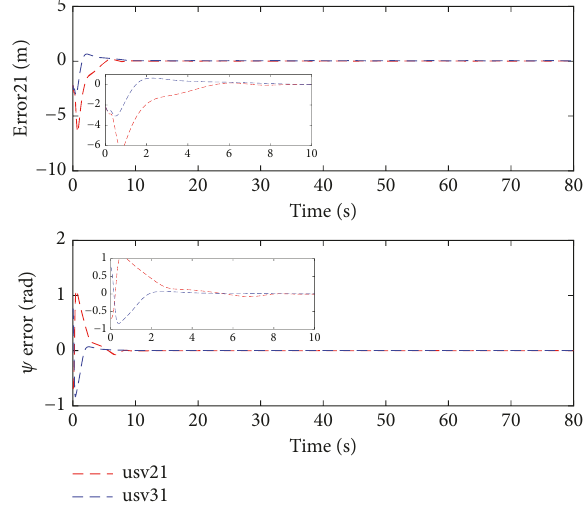
Figure 9: The position and attitude of the three